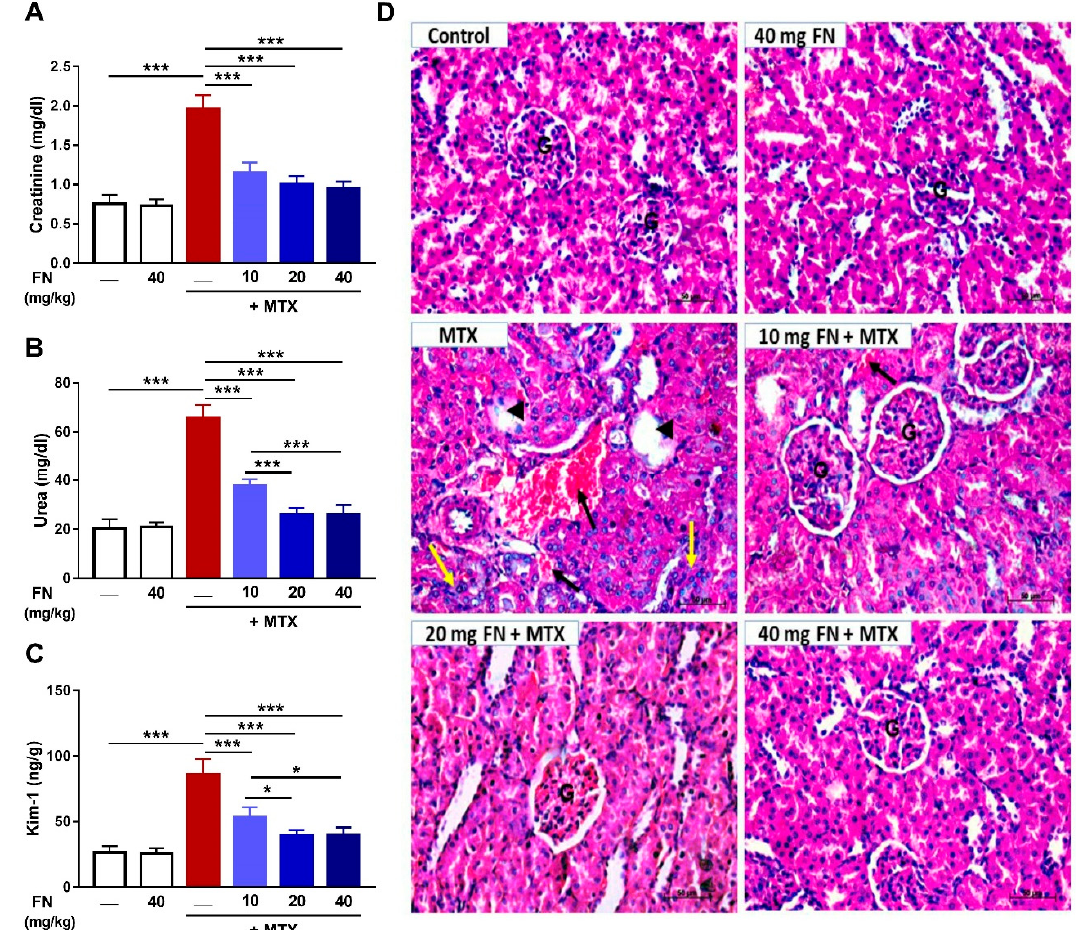
Figure 1. Formononetin (FN) prevents methotrexate (MTX)-induced renal dysfunction and injury. FN ameliorated serum creatinine ( A ) and urea ( B ) and renal kidney injury molecule-1 (Kim-1) ( C ) in MTX-administered rats. Data are mean ± SEM, ( n = 6). * p < 0.05 and *** p < 0.001. ( D ) Photomicrographs showing the normal structure of the glomeruli (G) and renal tubules in control and FN-treated rats, and interstitial hemorrhage (black arrow), glomerular atrophy and necrosis (arrowhead), and infiltration of leukocytes (yellow arrow) in MTX-intoxicated rats. FN prevented kidney injury induced by MTX with interstitial hemorrhage (black arrow) observed at the 10 mg / kg dose. (hematoxylin and eosin (H&E); X400) [Scale bar = 50 µ